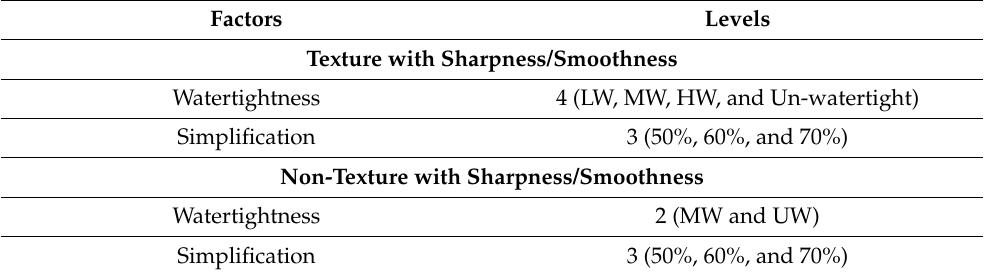
Table 1. Three-dimensional scanner factor levels.